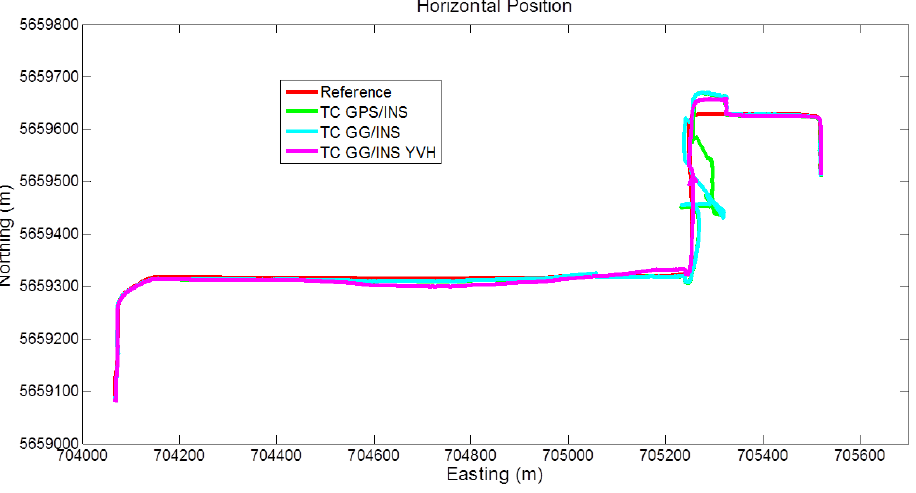
Figure 13. Trajectories obtained with the tight coupling approach (Segment 1).